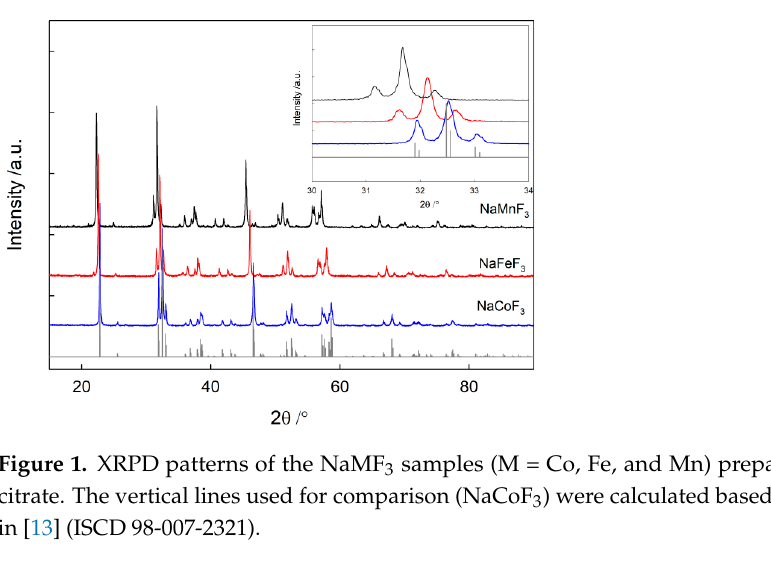
Figure 1. XRPD patterns of the NaMF 3 samples (M = Co, Fe, and Mn) prepared without sodium citrate. The vertical lines used for comparison (NaCoF 3 ) were calculated based on the data reported in [13] (ISCD 98-007-2321).